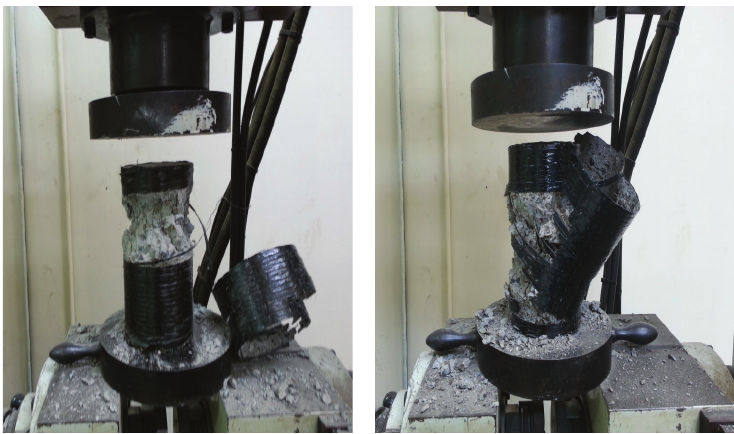
Figure 7: Failure of CFRP wrapped